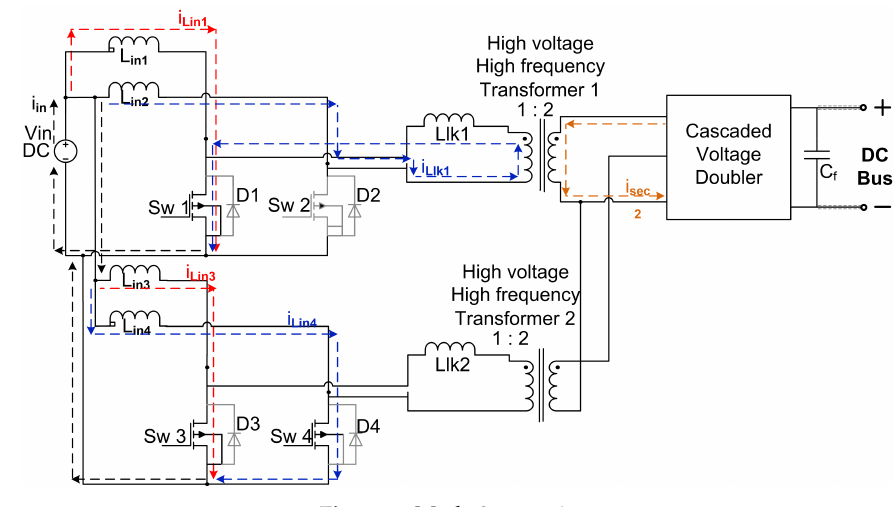
Figure 4. Mode 2